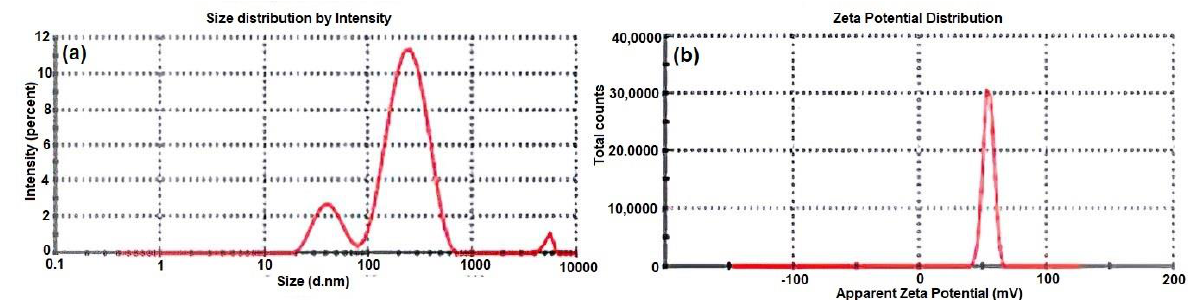
Figure 1. ( a ) PS and ( b ) ZP of the optimized formulation (MEM-NC3).